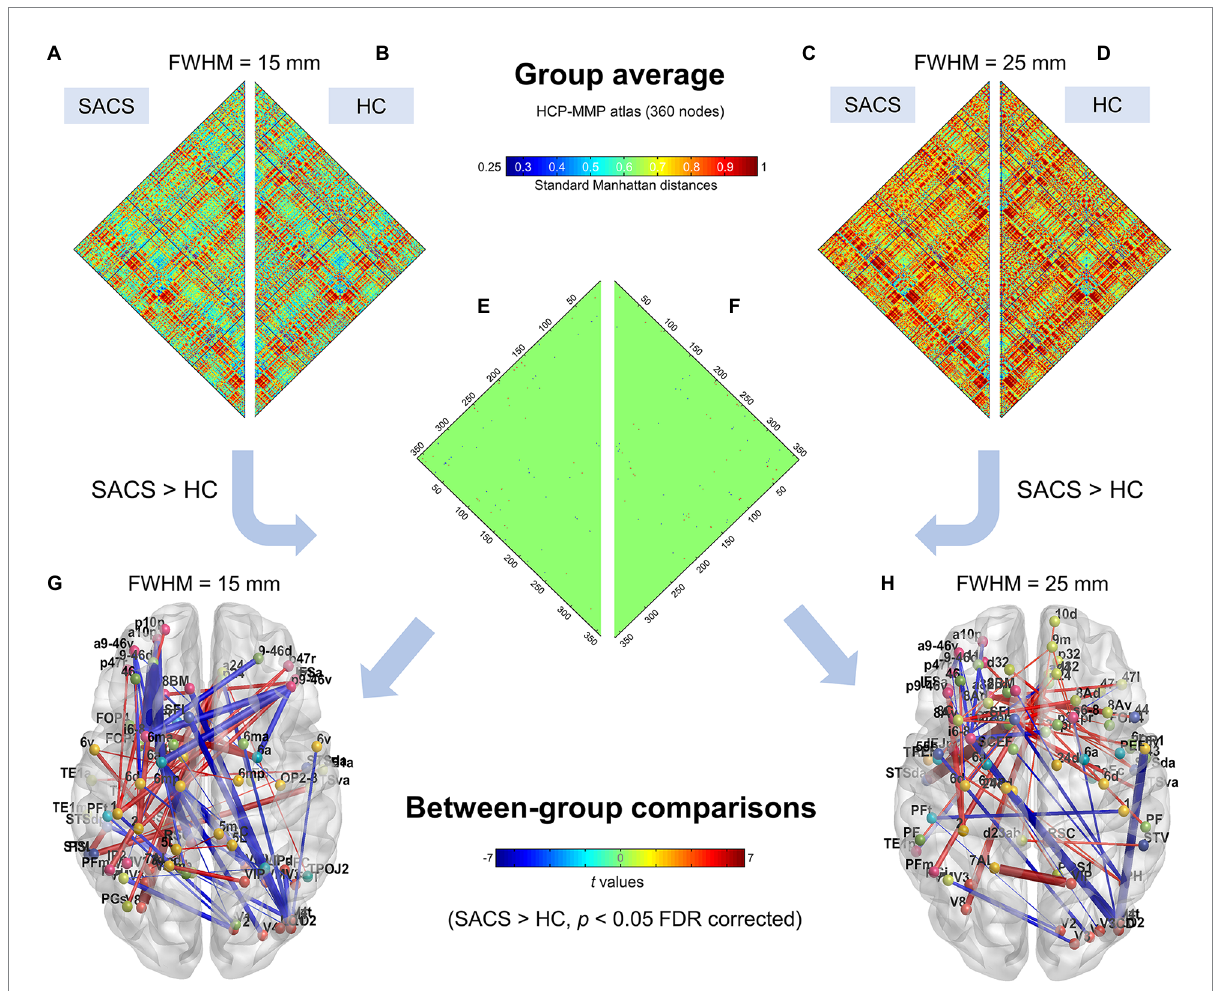
FIGURE 4 Individualized single-subject networks using the HCP-MMP atlas (360 parcels). Group average connectivity matrices for SACS patients (A,C) and healthy controls (B,D) with 15 mm and 25 mm smoothing kernels using the HCP-MMP atlas are shown. The colorbar shows standard Manhattan distances, with smaller values reflecting greater structural connectivity and vice versa. Subgraphs (E,F) show between-group differences on network connectivity with 15 mm and 25 mm smoothing kernels, respectively, which could be visualized as graphs. (G,H) The colorbar shows t values for the group statistics on the edges, with a positive t -value representing that the SACS patients had a longer Manhattan distance and thus a lower structural connectivity on the edge, and vice versa. LH, left hemisphere; RH, right